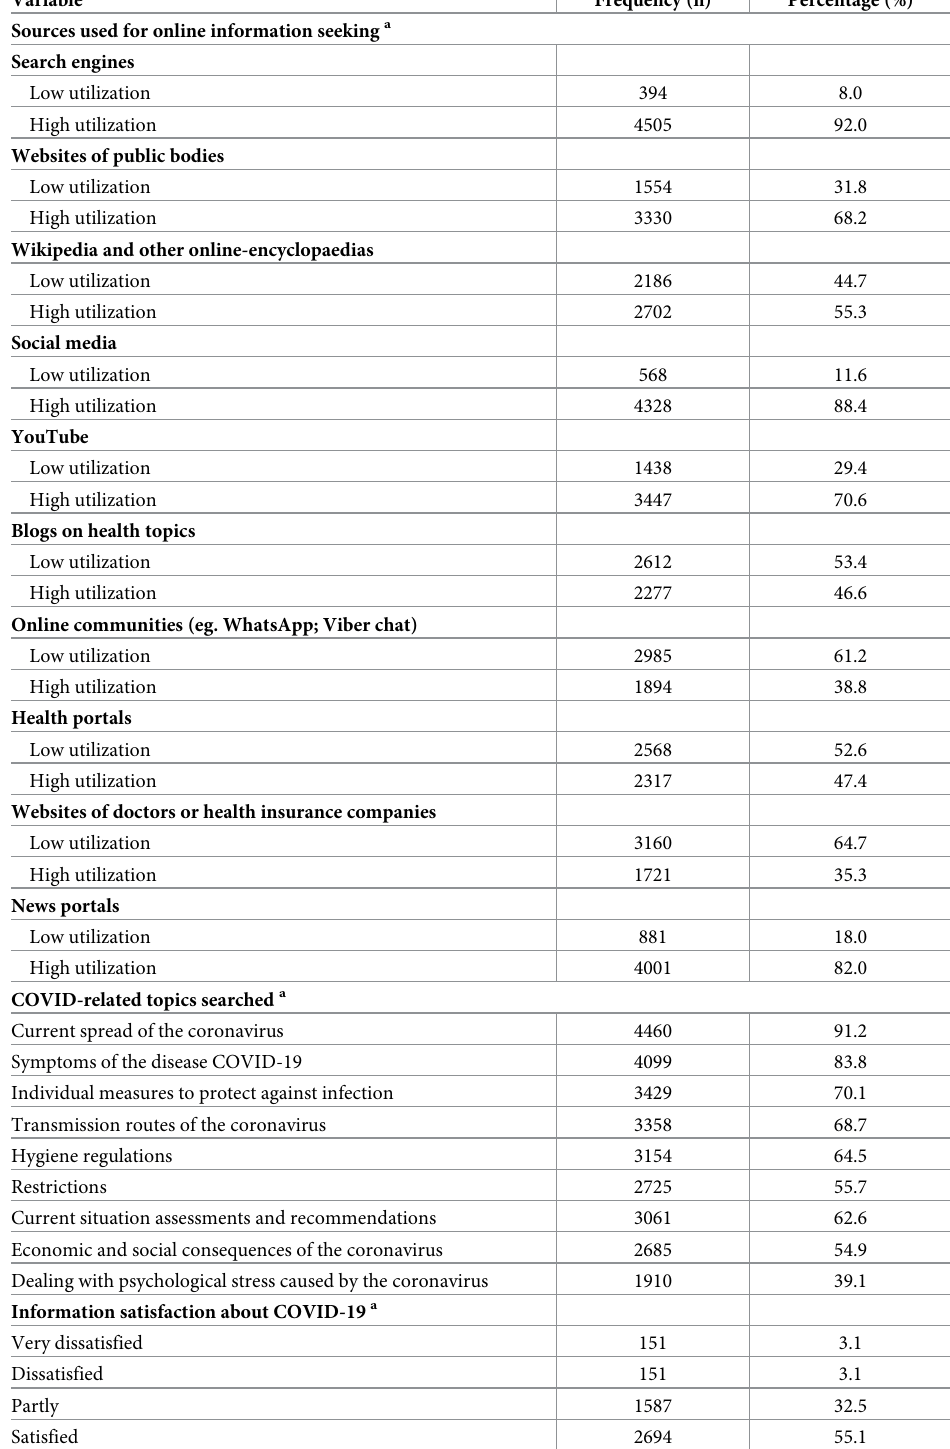
Table 2. Online information seeking patterns among university students from China, Malaysia, and the Philip- pines (n =